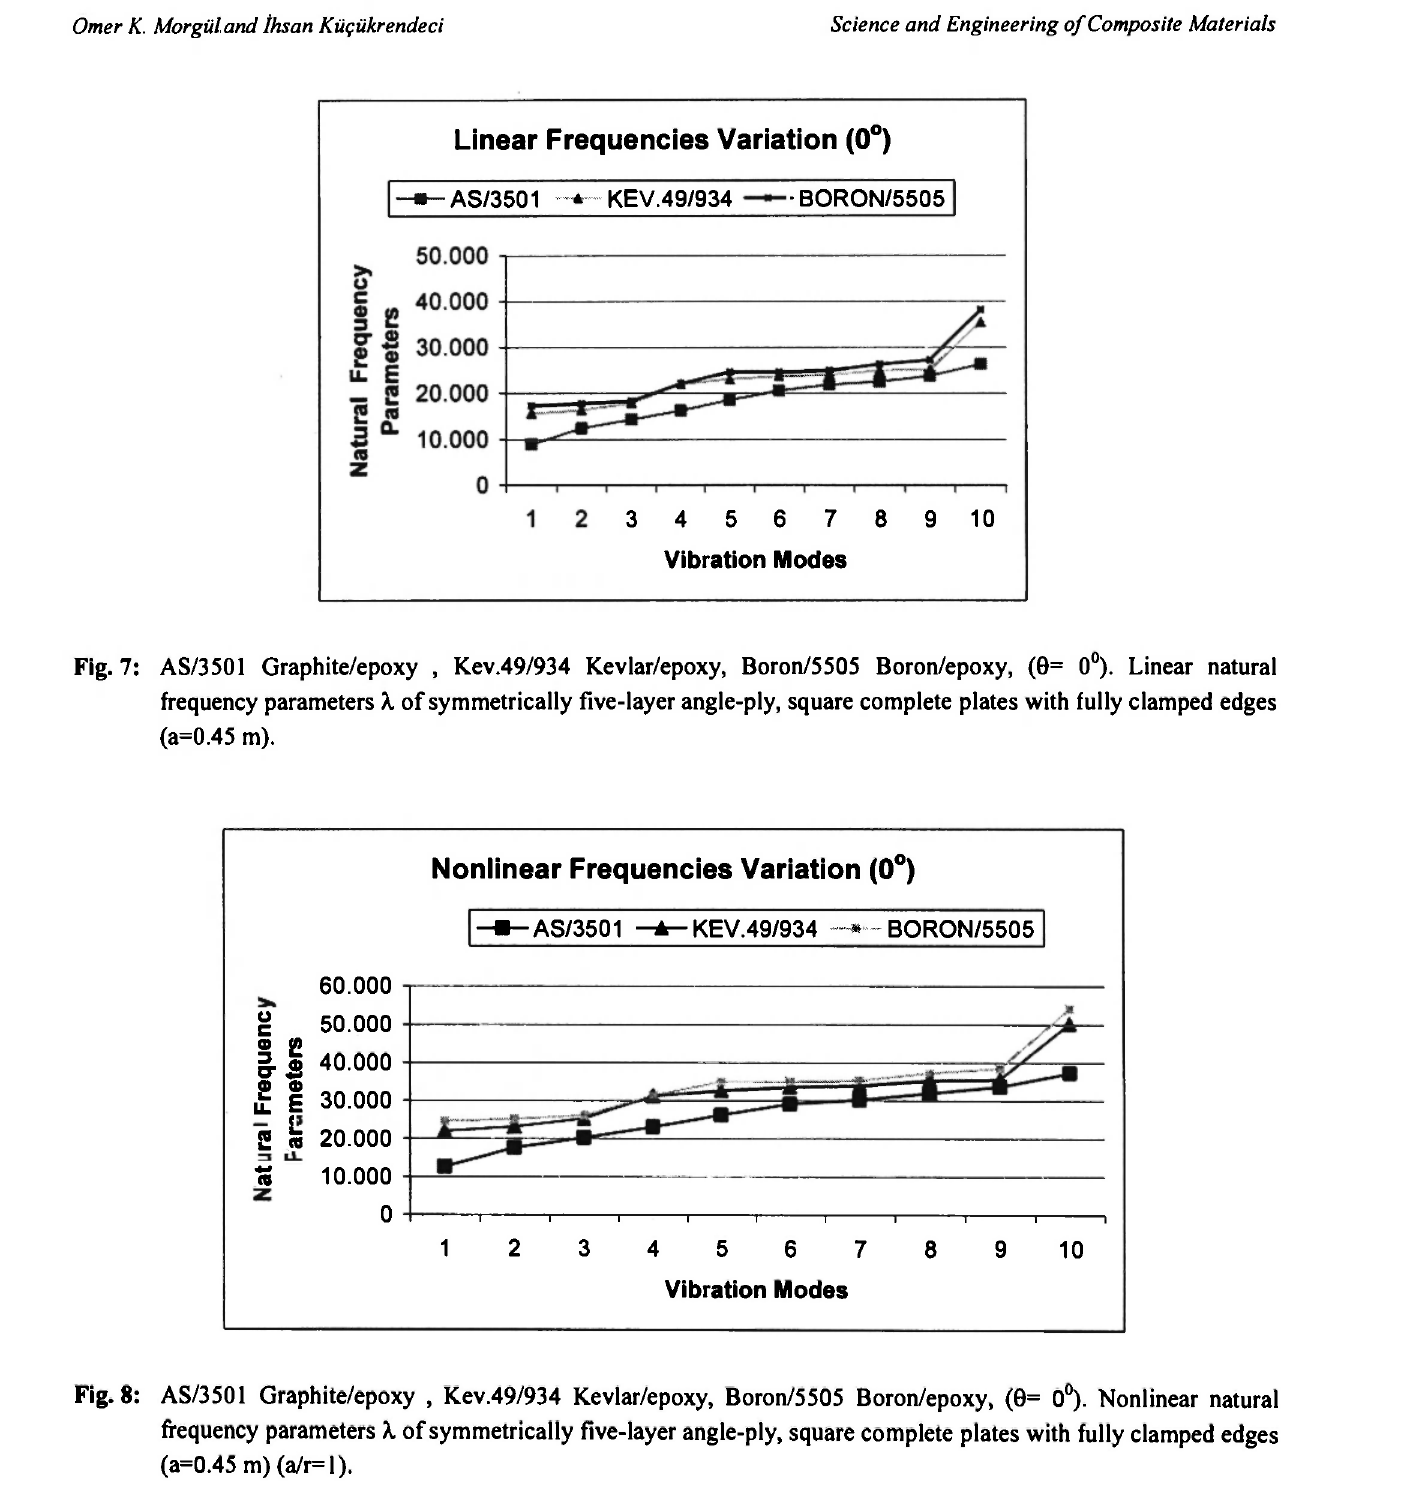
Fig. 8: AS/3501 Graphite/epoxy , Kev.49/934 Kevlar/epoxy, Boron/5505 Boron/epoxy, (θ= 0°). Nonlinear natural frequency parameters λ of symmetrically five-layer angle-ply, square complete plates with fully clamped edges (a=0.45 m)